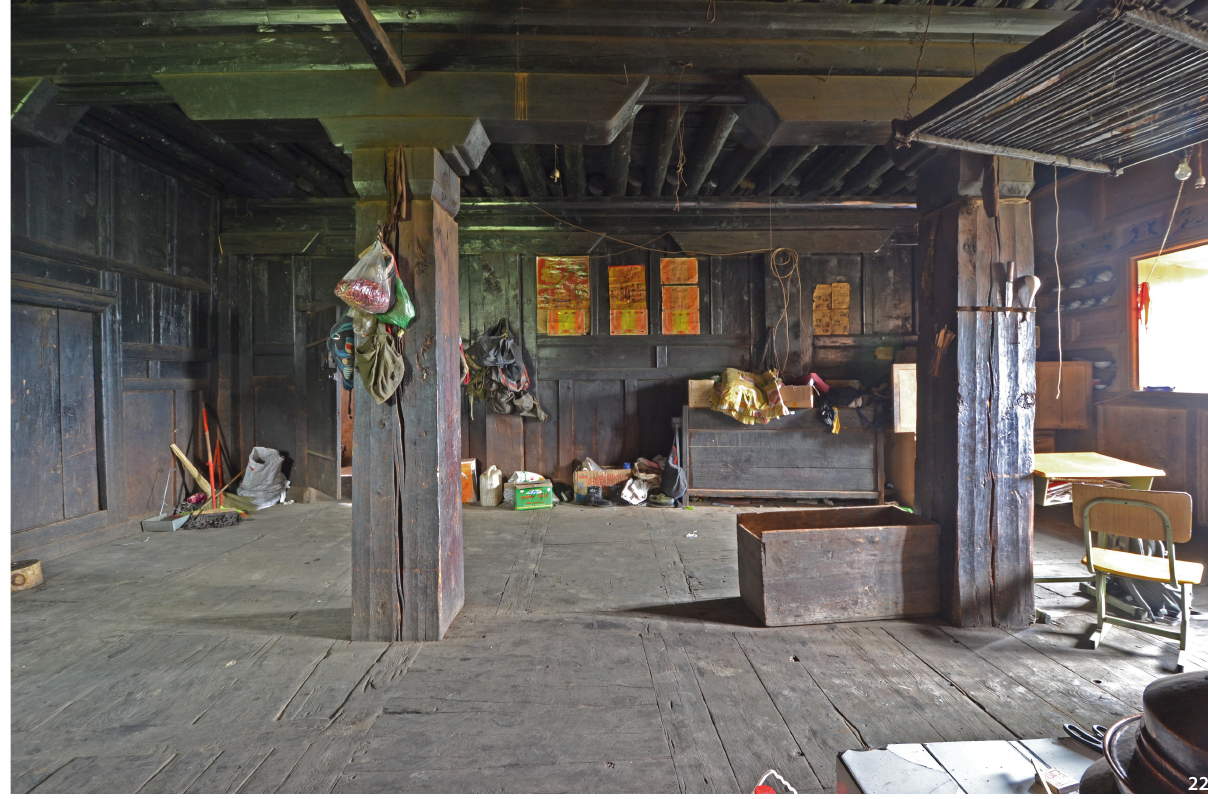
Figure 22 Interior of the kitchen/living room of the farmhouse in Dabpa (Source: the authors).